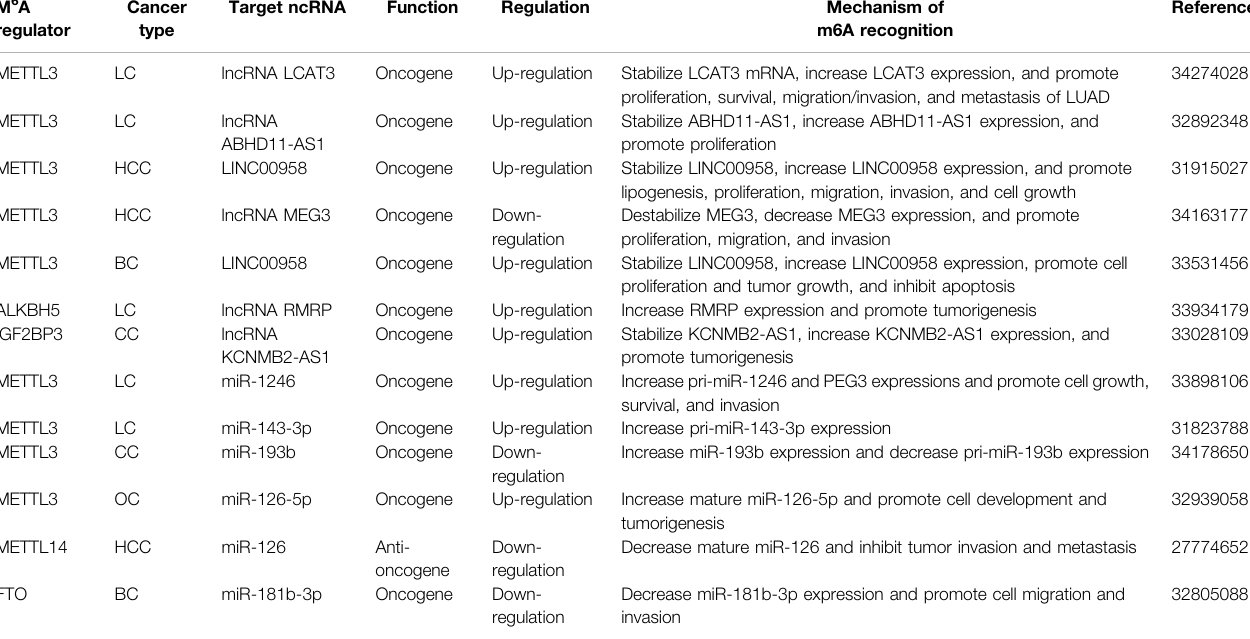
TABLE 2 | M 6 A regulators-modi fi ed noncoding RNA in various cancers. M 6